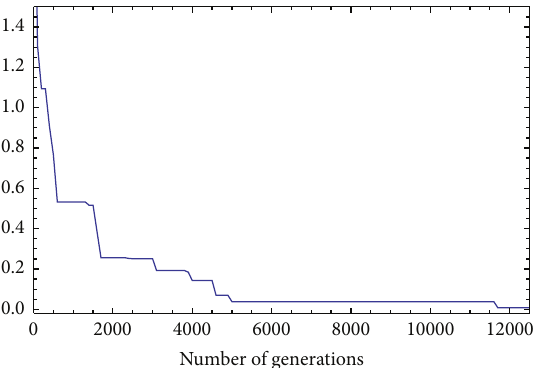
Figure 20: Performance graph for Case